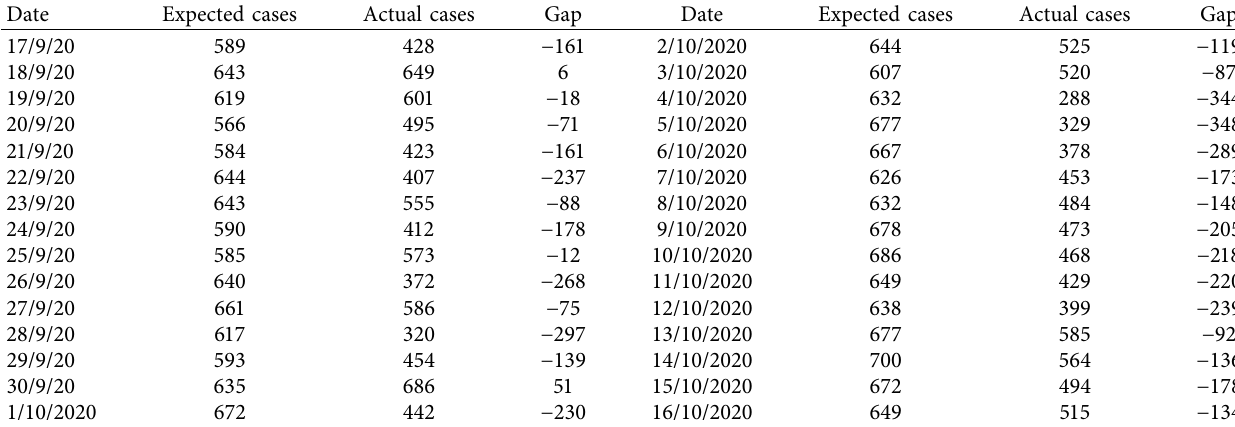
Table 11: The deviation between the actual and forecasted values of the daily confirmed COVID-19 cases in West Africa for the period between